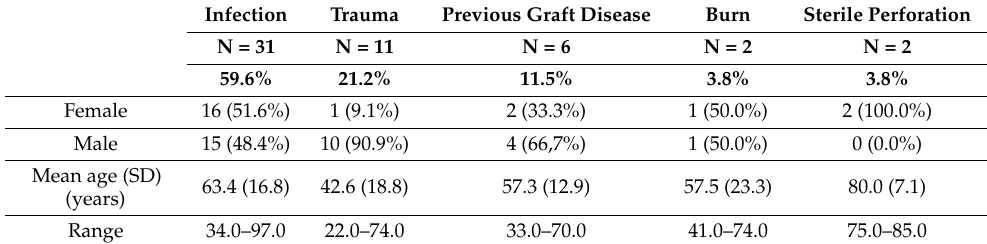
Table 1. Characteristic of the study group.